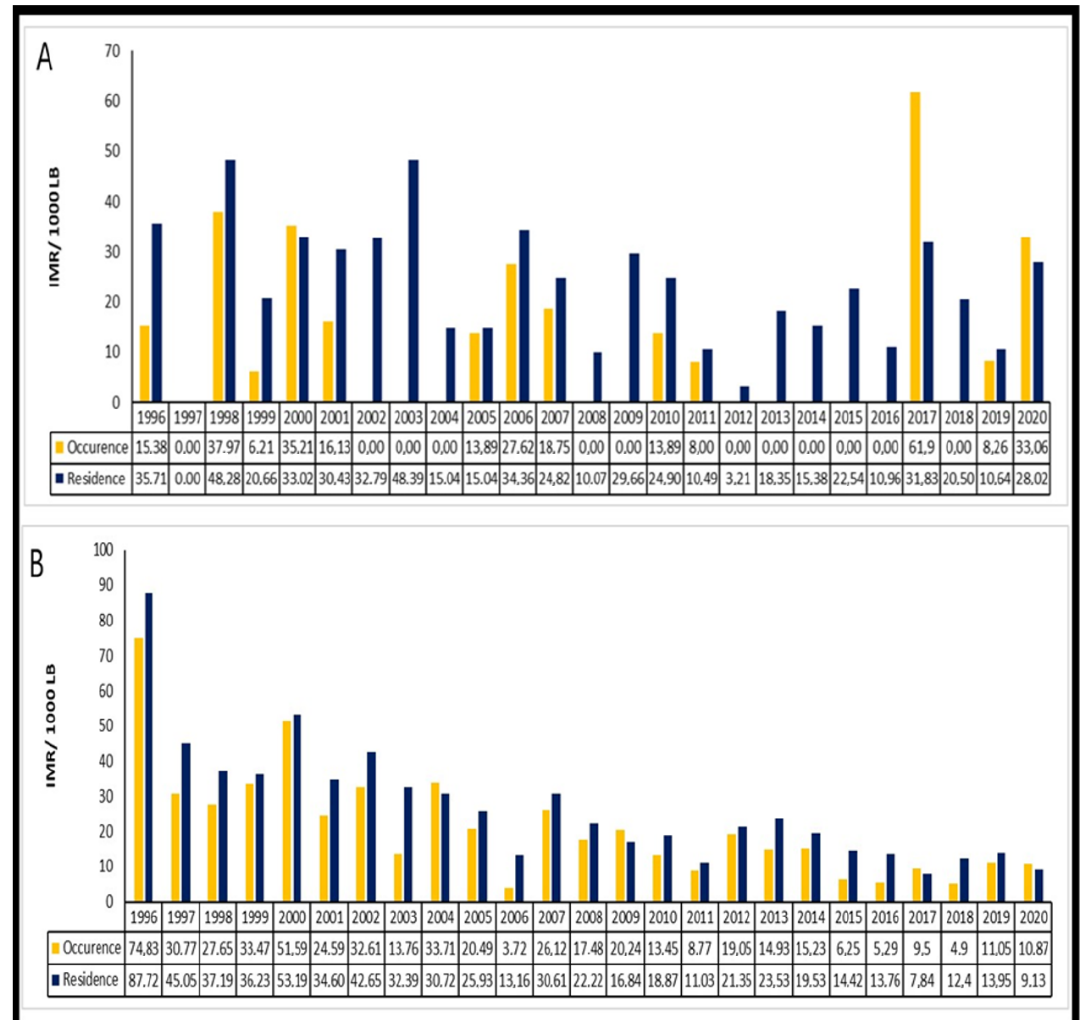
Figure 1. Comparison of infant mortality rate by occurrence and residence in the following selected cities in the North region: ( A ) Bonfim and ( B ) Pacaraima. Brazil, 1996–2020. In the Midwest region, there was, in general, a decrease in IMR over the years, with the exception of Paranhos and Mundo Novo. The latter showed an increase in IMR in the last period, from 18.79 to 21.39 deaths per 1000 LB (Table S3). The South region also presented an absence of data, with the cities of Acegu á , Barra do Quara í , Chu í and Porto Mau á not being tabulated as they did not have data available for calculating the IMR and only half of the cities had information on recent years. Among the cities in the South region that presented available data, most had low IMRs, with the exception of the city of Quara í , where mortality was higher, with the IMR per residence classified as an average with 21.67 deaths/1000 LB in 2020. Additionally, in the South region, the Twin Cities Foz do Iguaçu-PR, Dion í sio Cerqueira and Santo Ant ô